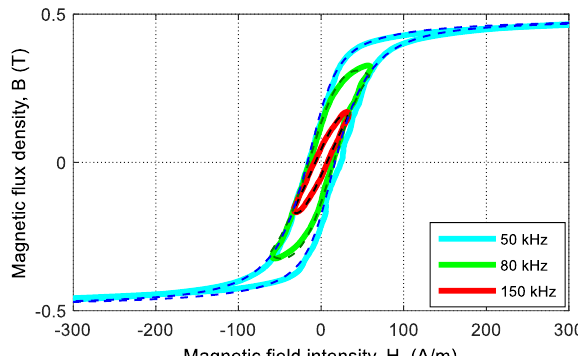
Figure 8. B ( H ) curves for the prototype under different operation frequencies. Model (dotted line) versus experimental results (solid